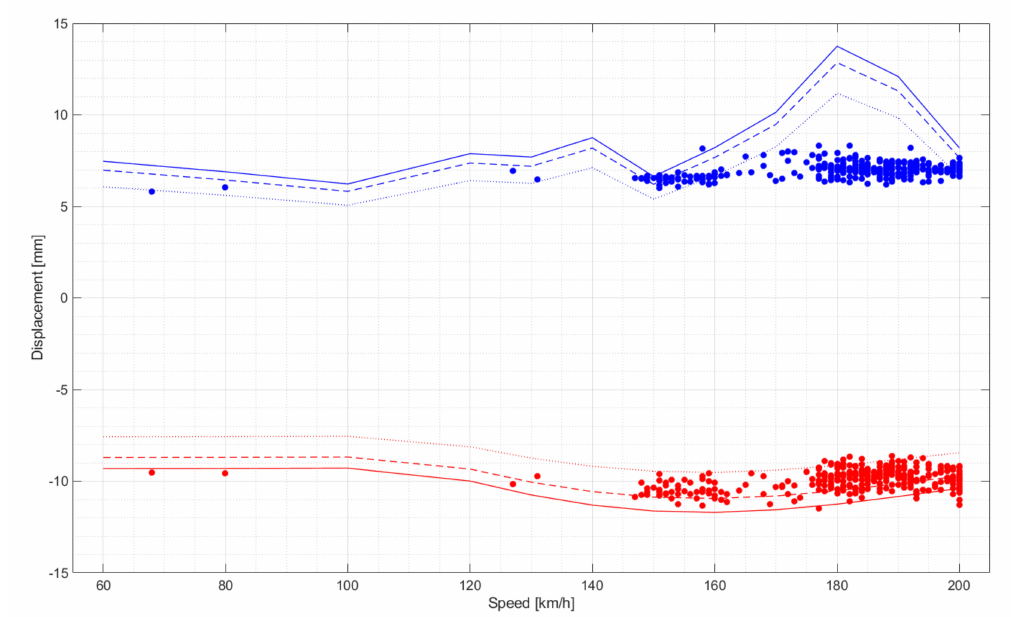
Figure 16. An example of displacement monitoring under the load of multiple-unit trains ED250 for one month (December 2017): Extreme displacement versus speed; red dot—minimum, blue dot—maximum; three red and blue lines correspond to the numerically determined extreme deflections from an empty train (dotted line), the state of normal use (dashed line), and the overloaded state foreseen by the manufacturer (solid